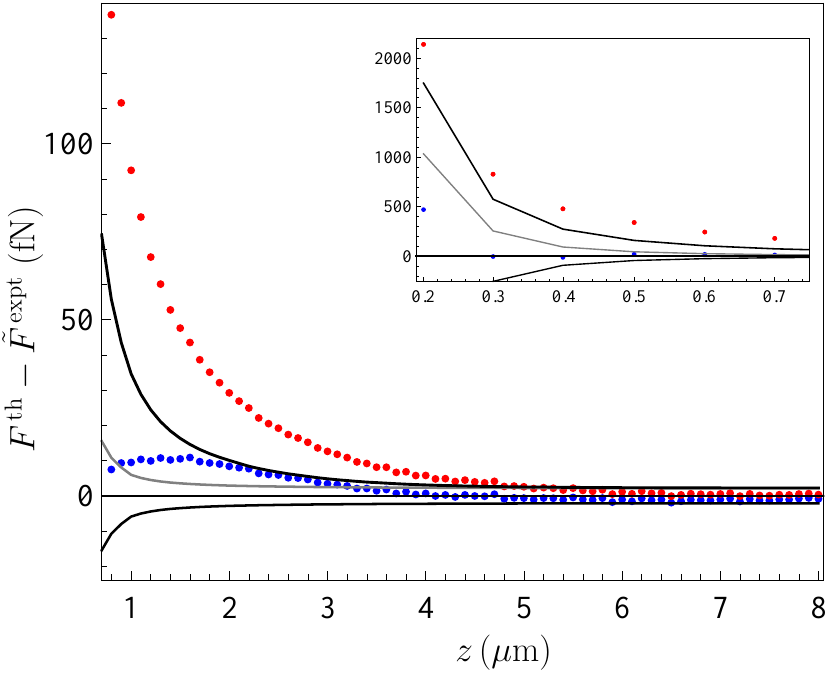
Figure 16. The differences between theoretical, computed using the Drude and plasma model extrapolations of the optical data, and experimental Casimir forces are shown by the red and blue dots, respectively, as the functions of separation. The black solid lines indicate the borders of the confidence band found at the 95% confidence level. The gray line shows the upper border of the confidence band as it would be in the absence of patches. The region of separations below 0.8 µ m is shown on an